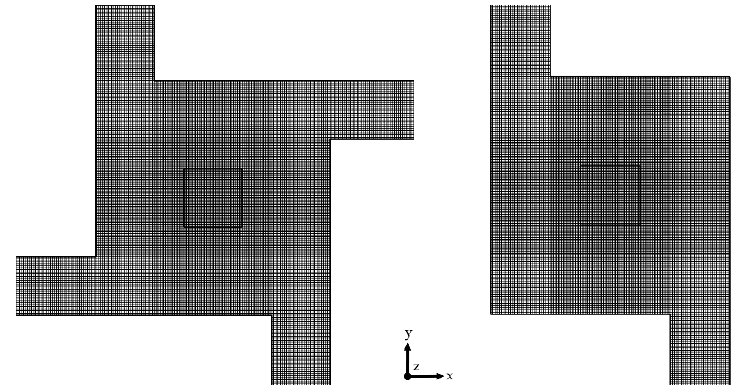
Figure 4. Orientation of structured hexahedron mesh elements in the computational domains.